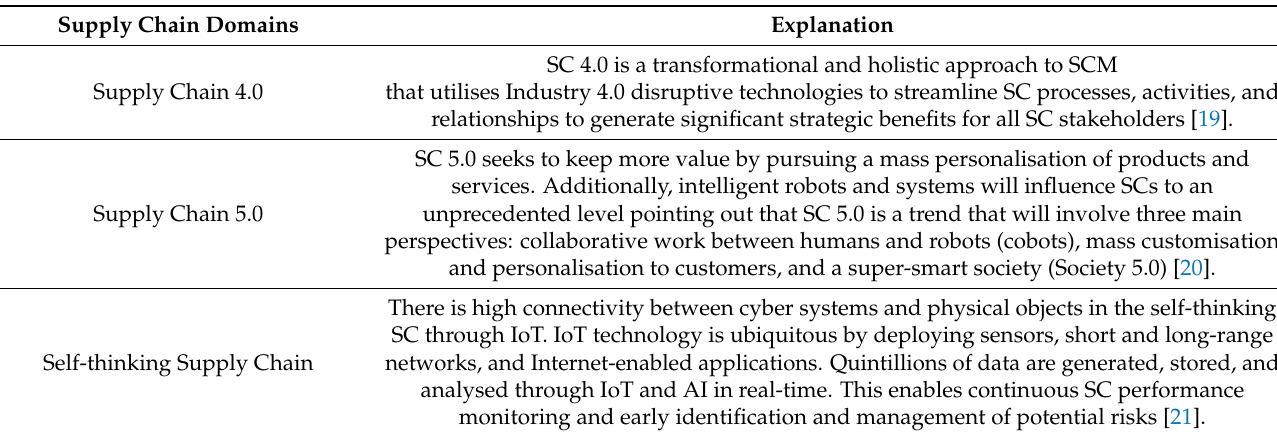
Table 1. Supply chain domains and